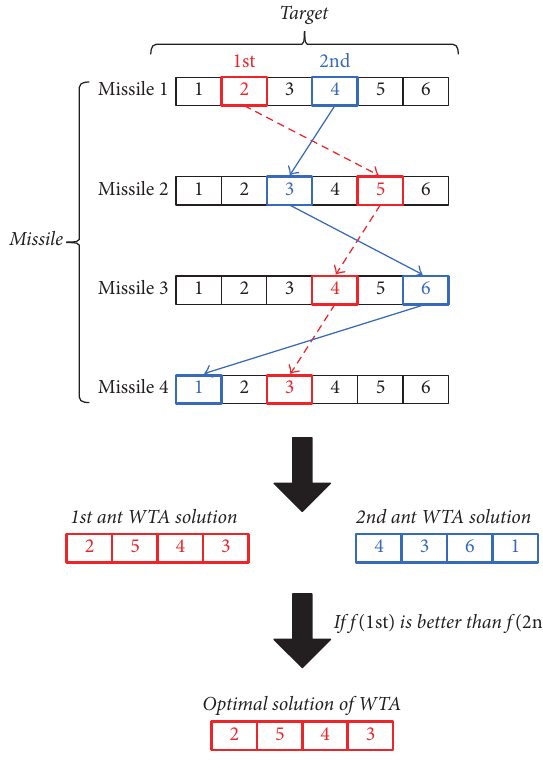
Figure 3: Example of WTA solutions (2 ants, 4 missiles, and 6